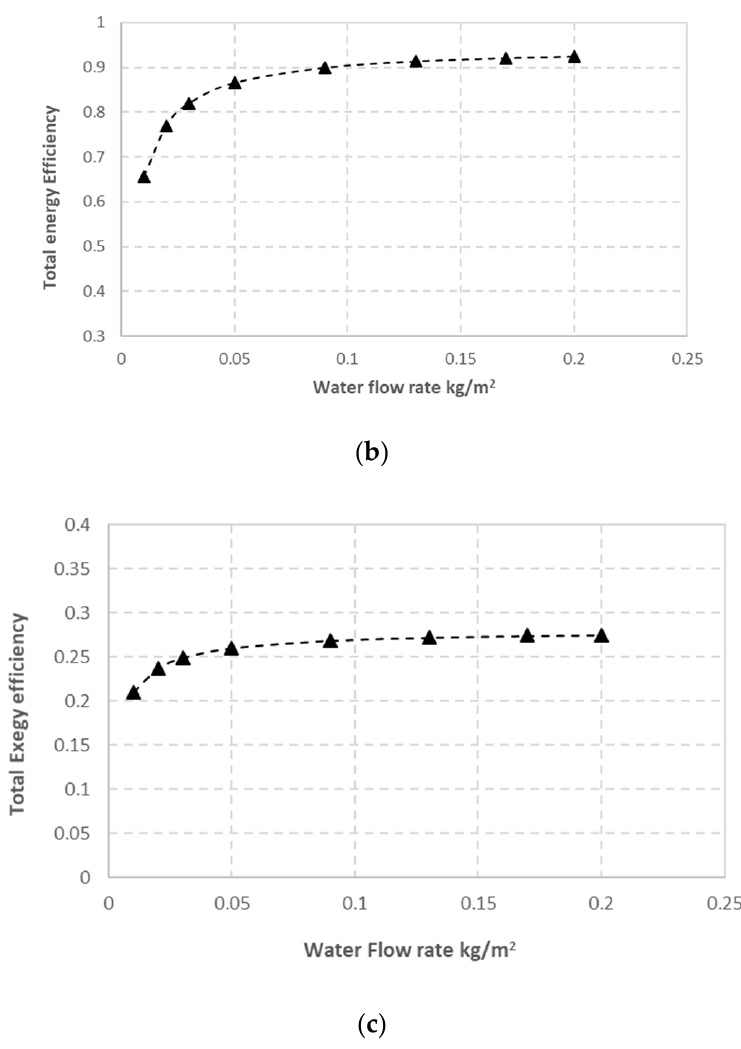
Figure 19. The in fl uence of coolant water fl ow rate on ( a ) average temperature of panel ( b ) total Figure 19. The influence of coolant water flow rate on ( a ) average temperature of panel ( b ) total energy e ffi ciency ( c ) total exergy. energy efficiency ( c ) total